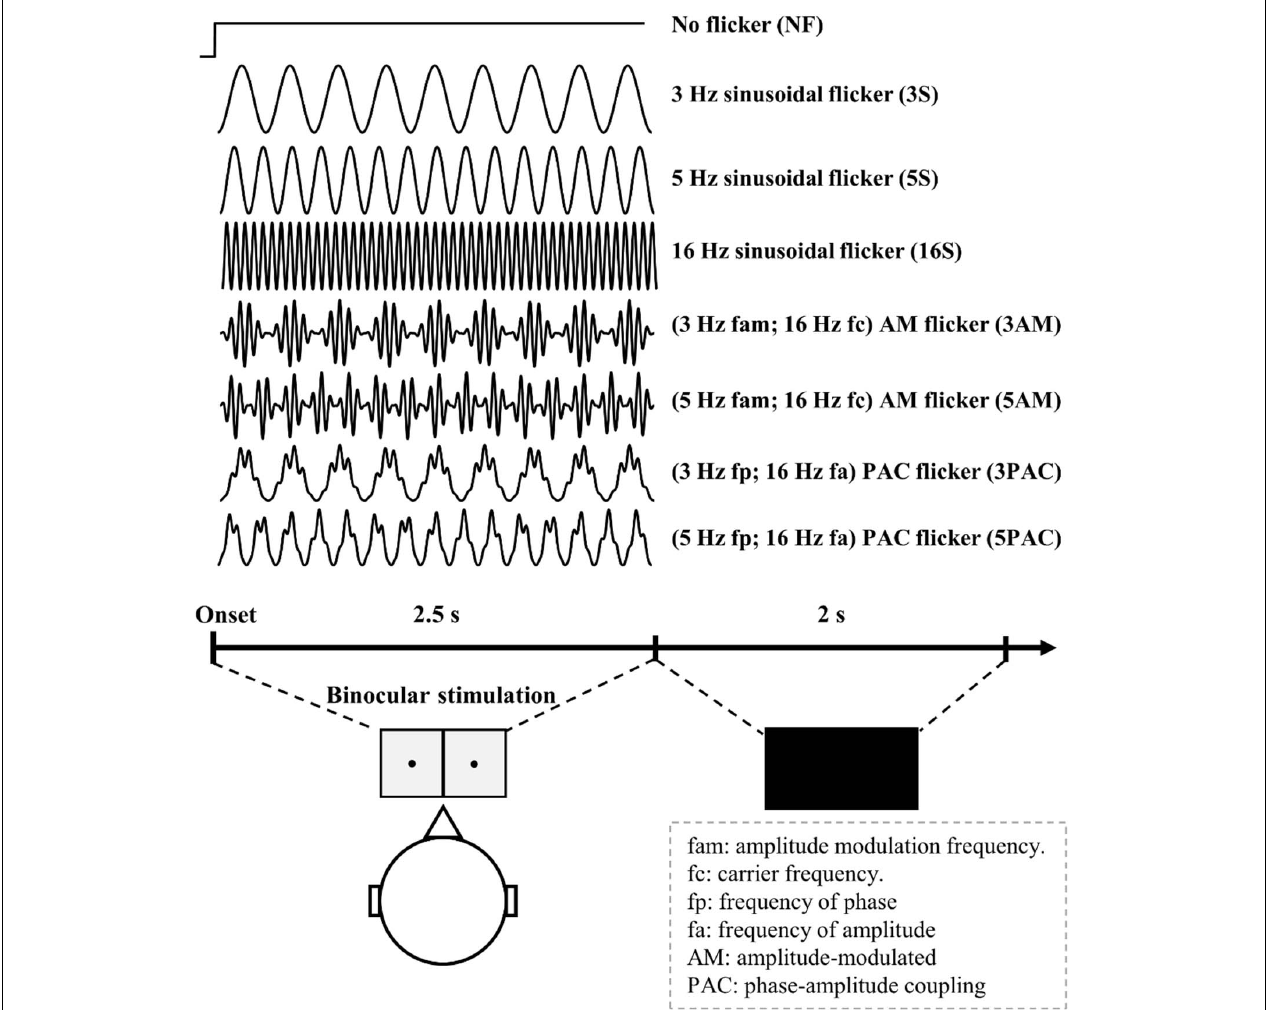
FIGURE 2 | The experimental procedure for Experiment 1. Participants opened their eyes after hearing a beep sound. Various light flicker stimuli were presented to participants in a randomized order with a time duration of 2500 ms for each. After stimulation, participants could close their eyes and rest until the next trial. Light flicker stimulation was presented to both eyes